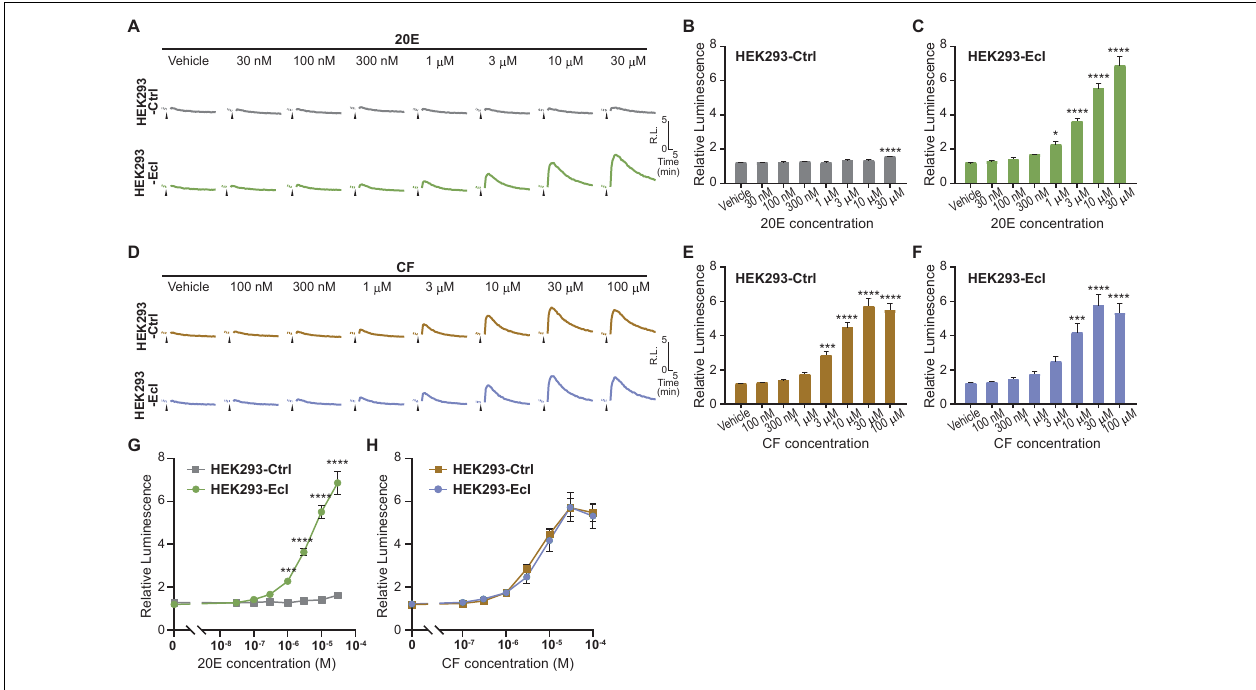
FIGURE 4 | Detection of 20E and CF entry into HEK293-EcI and -Ctrl cells using the NanoBiT assay. (A) Mean time-course changes of the relative luminescence in HEK293-Ctrl or -EcI cells transfected with RXR-SmBiT and EcR-LgBiT reporters in response to different doses of 20E. (B,C) Maximum relative luminescence in response to different doses of 20E in HEK293-Ctrl (B) or -EcI (C) cells. Bars represent means ± S.E.M. ( n = 4). One-way ANOVA analysis identified a significant effect in HEK293-Ctrl cells [ F ( 7 , 24 ) = 7.11, p < 0.001, (B) ] and HEK293-EcI cells [ F ( 7 , 24 ) = 79.05, p < 0.0001, (C) ]. * and **** indicate p < 0.05, and 0.0001, respectively, from multiple comparisons to the vehicle treatment using Dunnett’s correction. Note that the larger variance across the samples in the HEK293-EcI cell data reduces the significances of the individual comparisons in a way which does not occur in the HEK293-Ctrl cells hence the smaller difference in panel (B) accounting for more significance in the multiple comparisons compared to that observed in panel (C) . (D) Mean time-course changes of the relative luminescence in HEK293-Ctrl or -EcI cells transfected with RXR-SmBiT and EcR-LgBiT reporters in response to different doses of CF. (E,F) Maximum relative luminescence in response to different doses of CF in the HEK293-Ctrl (E) or -EcI (F) cells. Bars represent means ± S.E.M. ( n = 4). One-way ANOVA analysis identified a significant effect in HEK293-Ctrl cells [ F ( 7 , 24 ) = 62.65, p < 0.0001, (E) ] and HEK293-EcI cells [ F ( 7 , 24 ) = 23.29, p < 0.0001, (F) ]. ***, and **** indicate p < 0.001, and 0.0001, respectively, from multiple comparisons to the vehicle treatment using Dunnett’s correction. (G,H) 20E (G) and CF (H) dose-response relationship in HEK293-Ctrl and -EcI cells. All values are the means ± S.E.M. ( n = 4) replotted from panels (B,C,E,F) . Two-way ANOVAs identified a significant interaction of the 20E concentration with EcI expression [ F ( 7 , 48 ) = 69.72, p < 0.0001, (G) ] and only a main effect of CF concentration, independent of EcI expression [ F ( 7 , 48 ) = 68.88, p < 0.0001, (H) ]. ***, and **** indicate p < 0.001, and 0.0001, respectively, from multiple comparisons using Sidak’s correction within each concentration of 20E between HEK293-Ctrl and HEK293-EcI